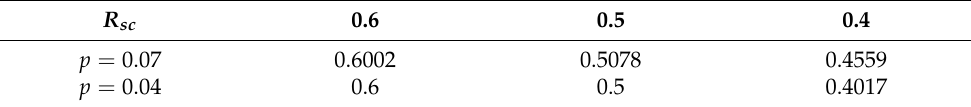
Table 1. Actual compression rate of the source polar coding.